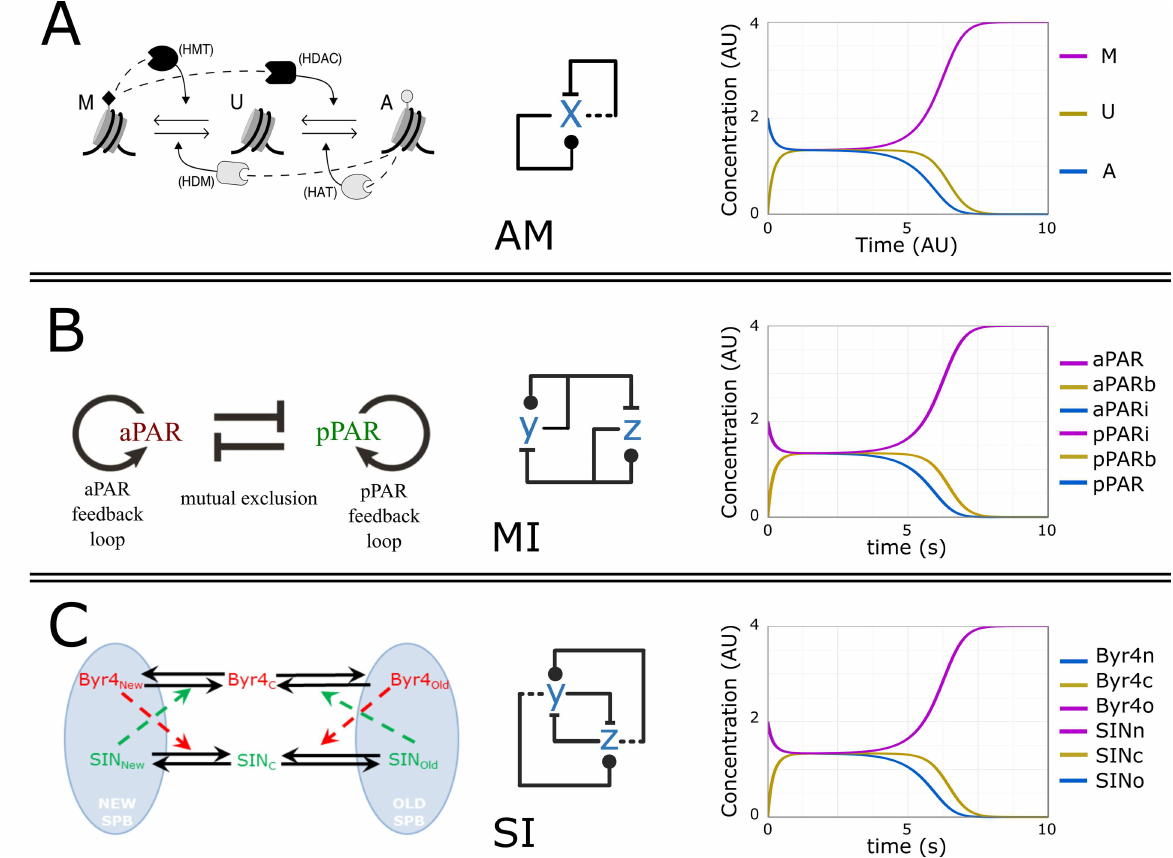
Fig 5. Biological networks with switching dynamics. (A) The epigeneticswitch model proposed by Dodd et al. (2007) [61]. (B) The polarityregulatorymodel of Motegi et al. (2013) [63]. (C) The septationinitiationnetwork asymmetry establishment model of Bajpaiet al. (2013) [64]. The middle panelsshow the respectivemodels with the condensednetwork notation, in which each node (molecule) represents three forms: inactive, non-decided,and active (Fig 2); the right panels show the behaviour of the models when initiatedfrom equal initial conditions and simulatedwith equal parameter values (all rates = 1). On panels B and C, only three traces are visible, as they totally overlap with the other three